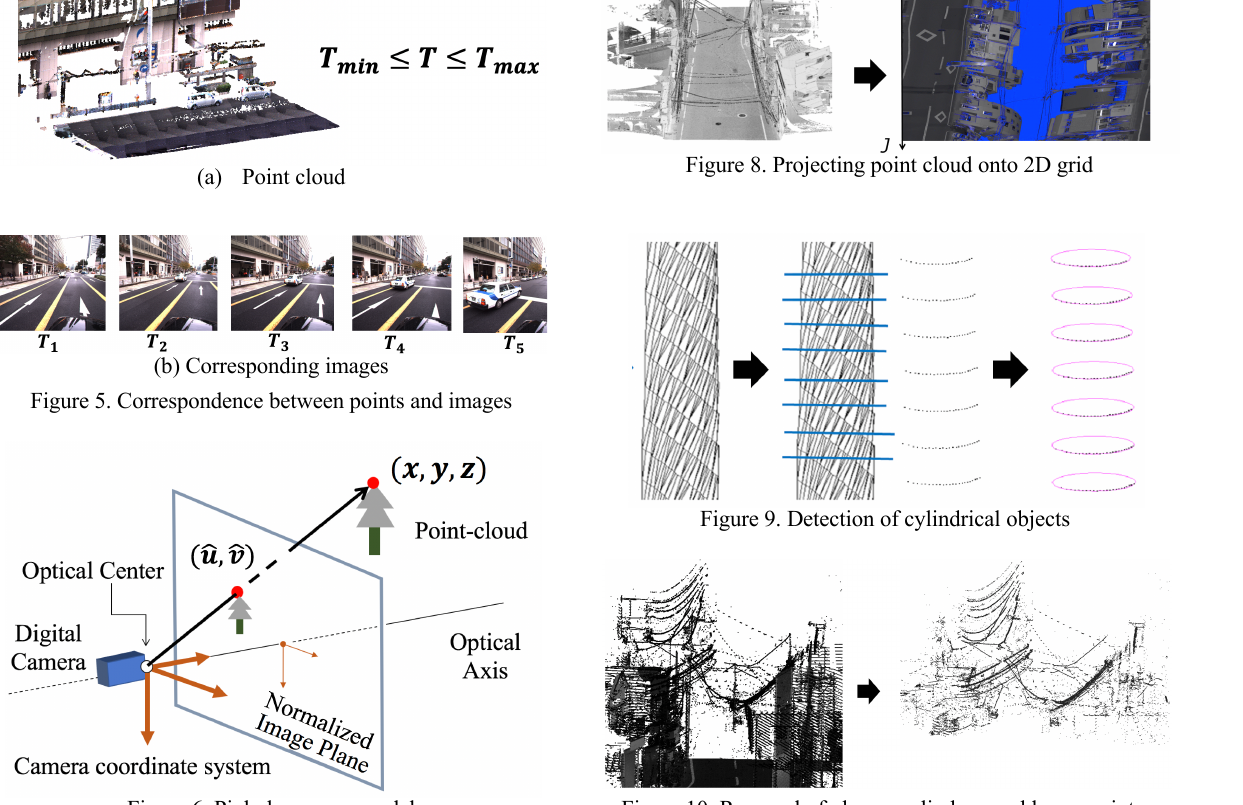
Figure 6. Pinhole camera model